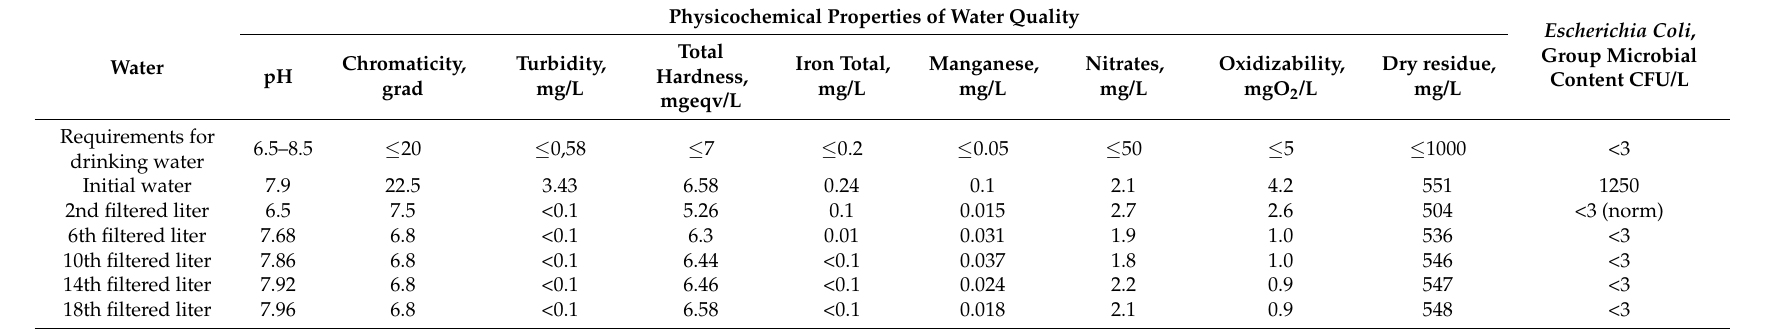
Table 3. Results of water analyzes before and after filtering through a 10 × 10 cm